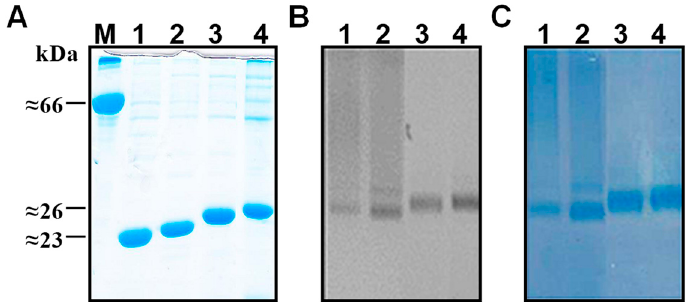
Figure 5. WB of 183preS1(20–47) and 183preS1phil proteins. ( A ) Blot with anti-HBc mAb13C9 [66]; ( B ) blot with anti-preS1 mAb MA18/7 [9]. Lane 1 — 183preS1(20–47), lane 2 — 183preS1phil, lane 3 — HBc183. M — Prestained Protein Molecular Weight Marker (26612, Pierce™). Normalized amounts of VLPs (10 µg) were used for SDS-PAGE .